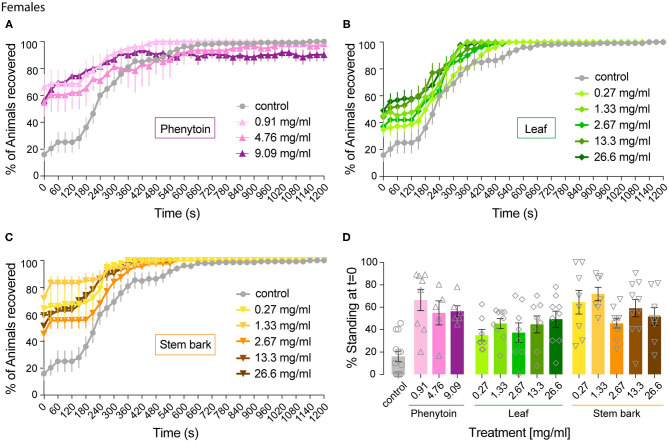
Effect of phenytoin and A. senegalensis leaf and stem extracts on recovery from seizures of parabss female flies. parabss flies treated with control food showed a very low percentage of flies recovered from seizures after mechanical perturbation, which improved over time. (A) Treatment with phenytoin increased the percentage of recovered flies at three different doses. (B) Treatment with A. senegalensis leaf extracts increased the percentage of flies recovered. (C)
A. senegalensis stem extract doses showed a greater effect than the leaf extract. (D) Dose response analysis at t = 0 for all treatments. Graphs show the mean % of flies seizuring ± SEM (for number of replicates, flies and significance values see Table 1).